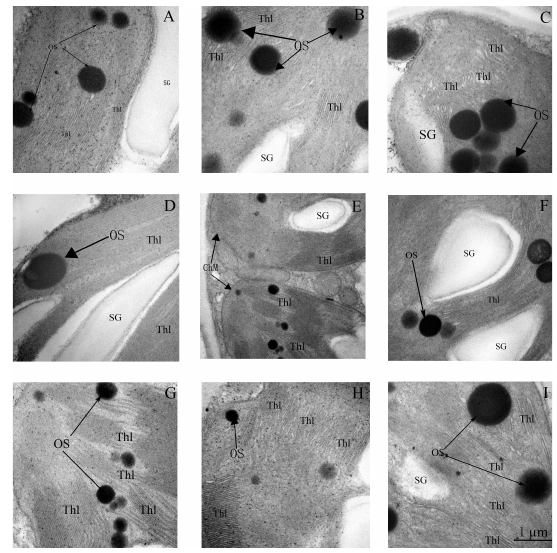
Figure 8. Ultrastructure of thylakoid membranes of leaves of black locust seedlings at three levels of salt stress (0, 100, or 200 mM NaCl), or with salt stress imposed after pretreatment with 1.04 µ M 24-epiBL by either seed soaking, foliar spraying, or roots dipping (see Table 1 for treatment designation). ( A ) CK;